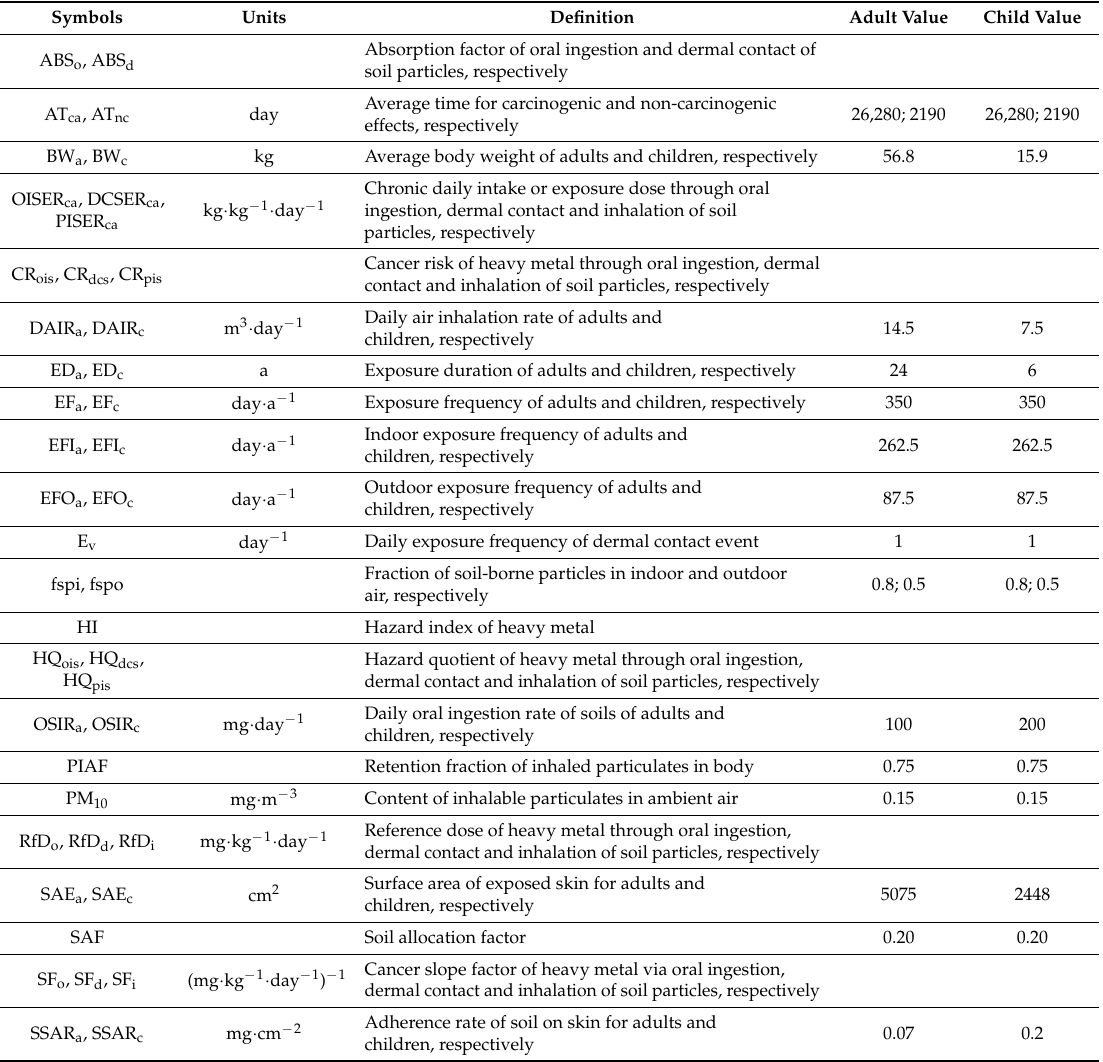
Table 2. Definition and reference value of some parameters for health risk assessment of heavy metals in soils